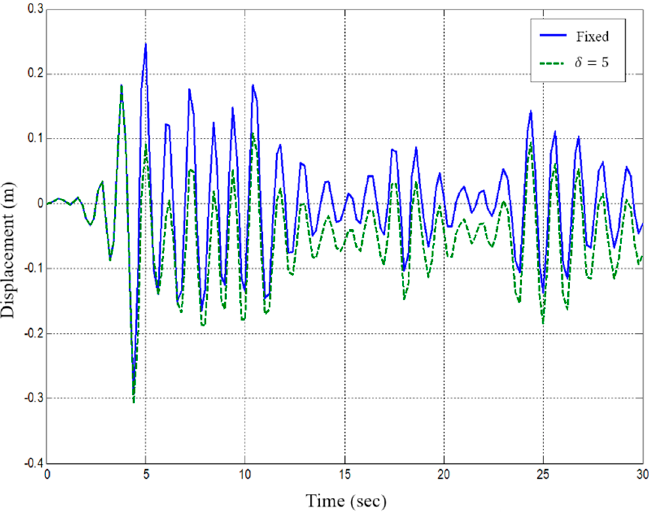
Figure 8. Time history of displacement for linear system and bilinear system.